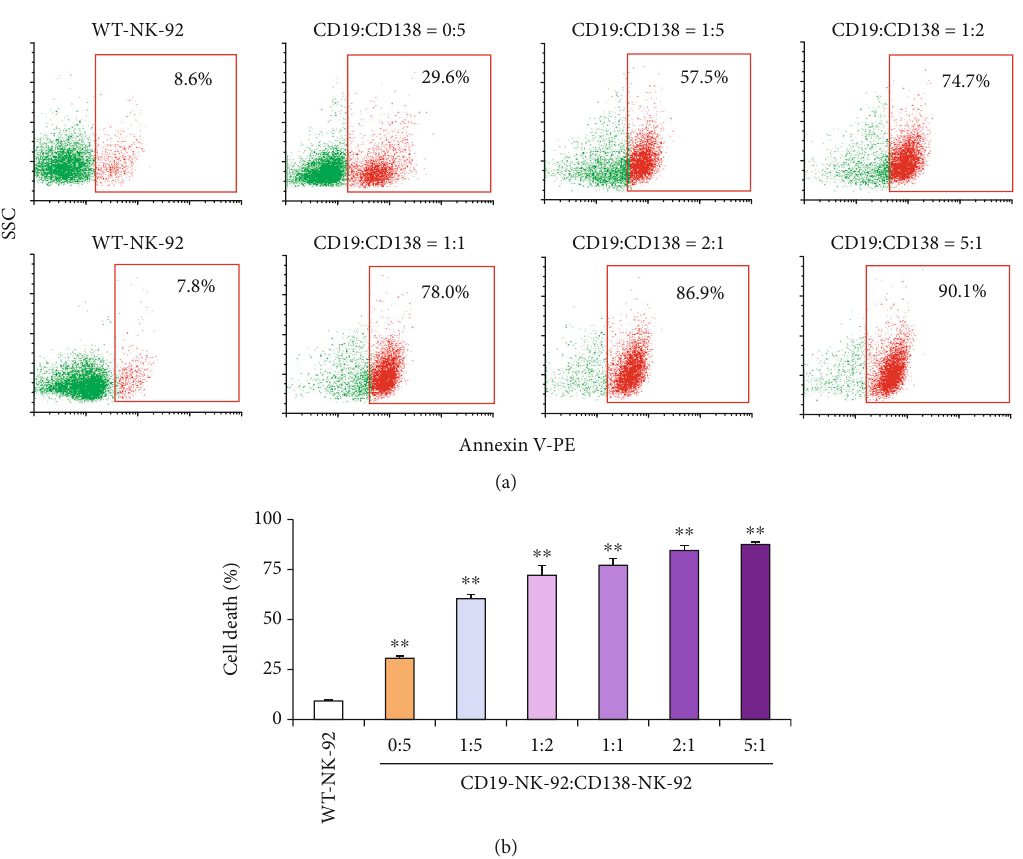
Figure 8: Cytotoxicity of the mixture of CD19-NK-92 and CD138-NK-92 cells toward ALL cells expressing CD19 and, to a lesser extent, CD138 antigens. (a) Human ALL-derived REH cells were labeled with PKH67 dye, incubated with WT-NK-92 cells or the mixture CD19-NK-92 and CD138-NK-92 cells at various ratios (0:5 ˗ 5:1) at the fi nal E : T ratio of 1:1 for 4h, and stained with Annexin V-PE. Representative fl ow cytometric dot plots of Annexin V-positive cells ( red box ) in PKH67-labeled cells were shown. (b) Percentage of REH cell death was plotted. Data are mean ± s : d : ( n = 3 ). ∗∗ p < 0 : 01 versus WT-NK-92 cells; two-sided Student ’ s t